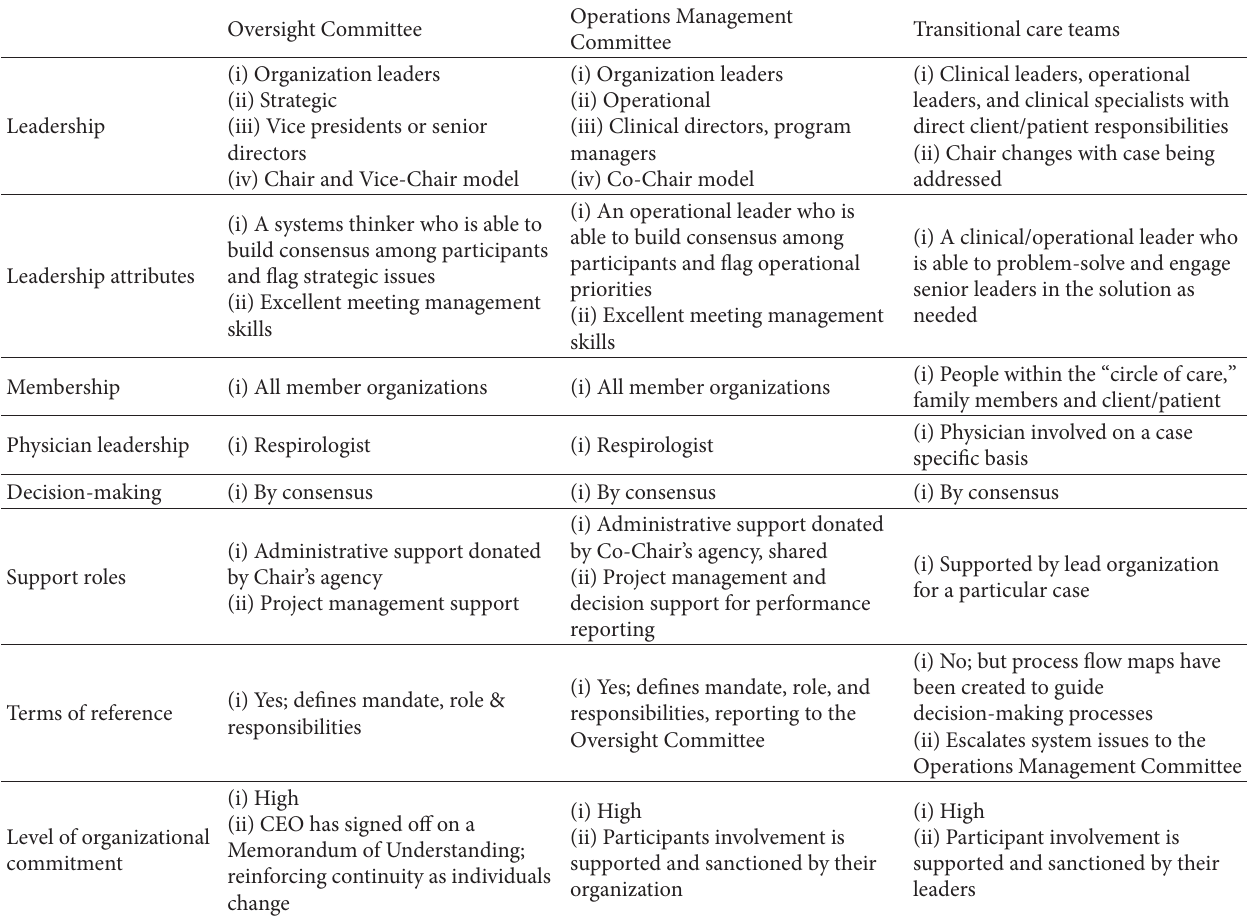
Table 2: Organizational structure